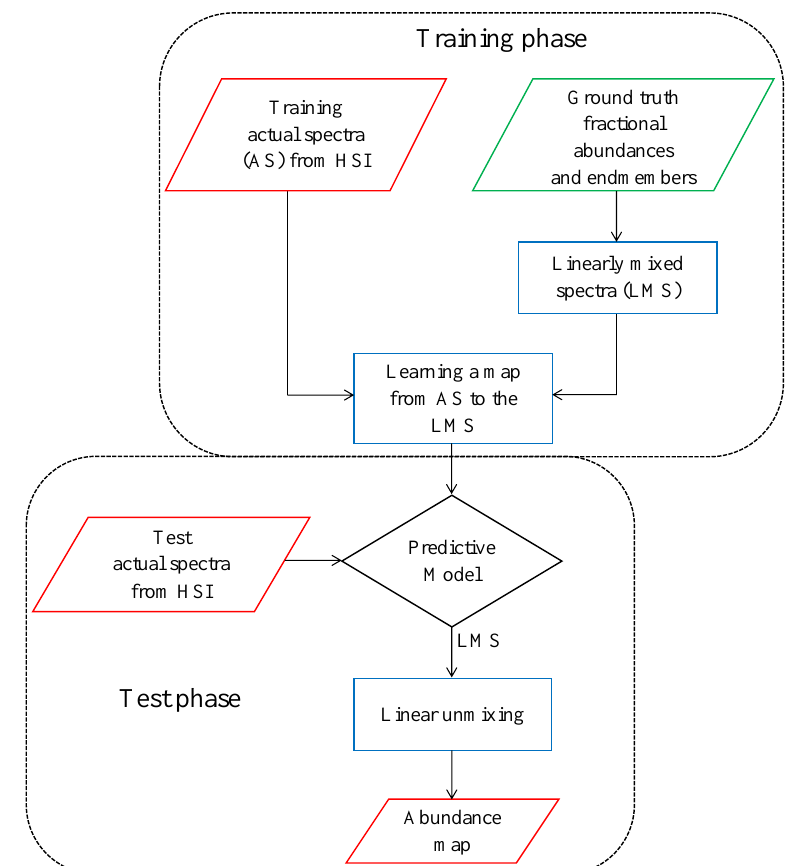
Figure 1. Flowchart of the proposed method. HSI refers to hyperspectral